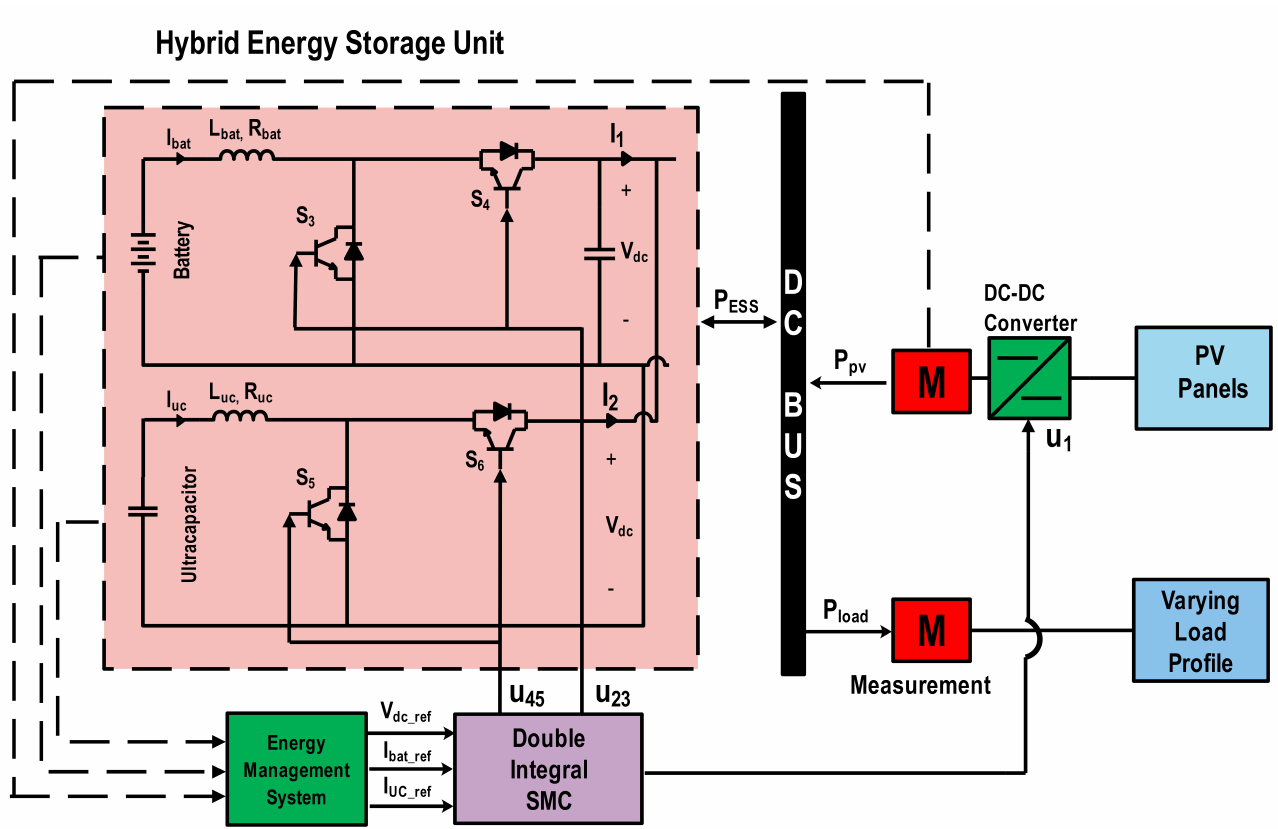
Figure 3. Schematic representation of hybrid energy storage